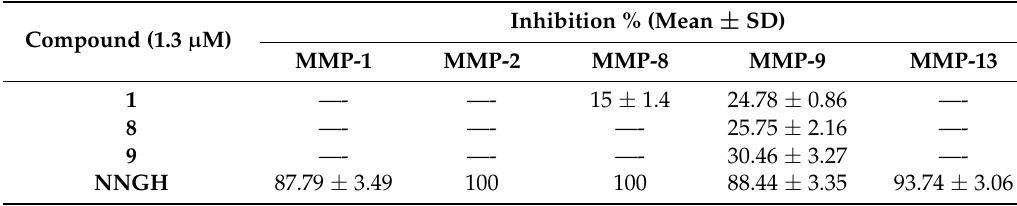
Table 2. MMPs Inhibition Percentage (%) of compounds 1 , 8 and 9